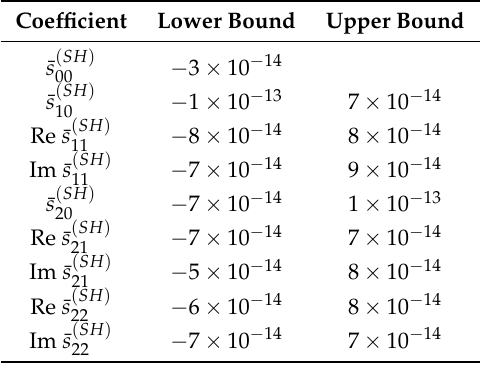
Table 7. Lower and upper limits on the SME coefficients decomposed in spherical harmonics derived from ˇCerenkov radiation [56]. Coefficient Lower Bound Upper